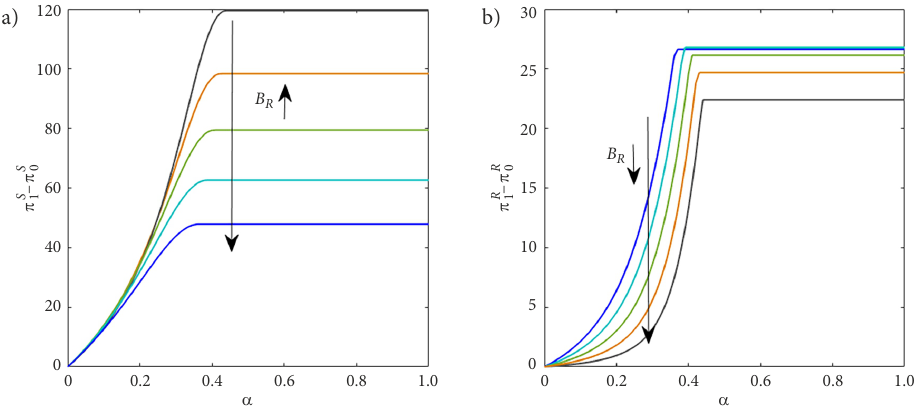
Figure 3. Impact of the retailer’s capital level for any division of